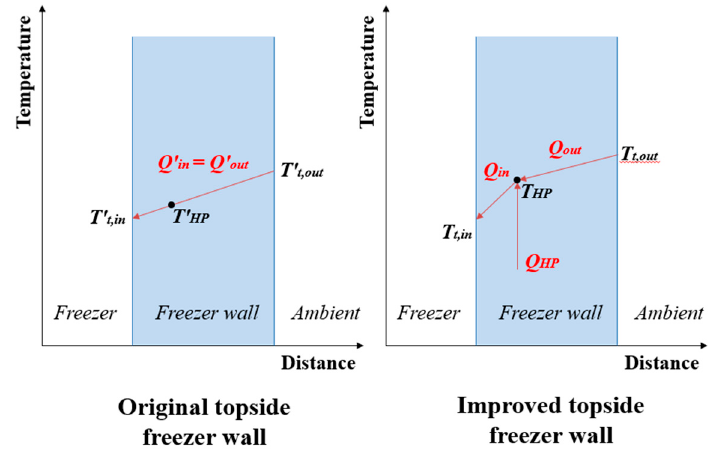
Figure 3. Heat transfer processes of original and modified topside freezer walls.